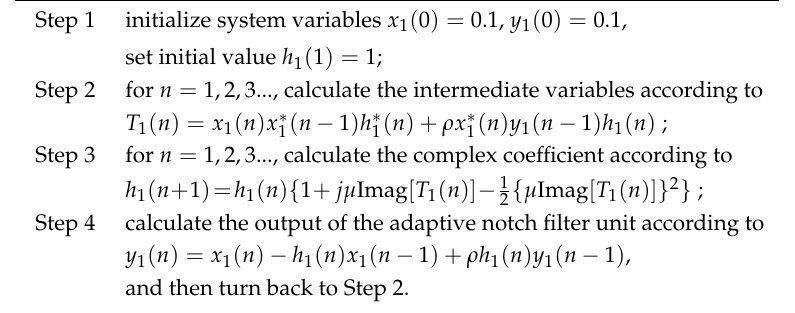
Table 1. The detailed procedure of the one order complex-coefficient notch filter unit with a single constrained zero-pole